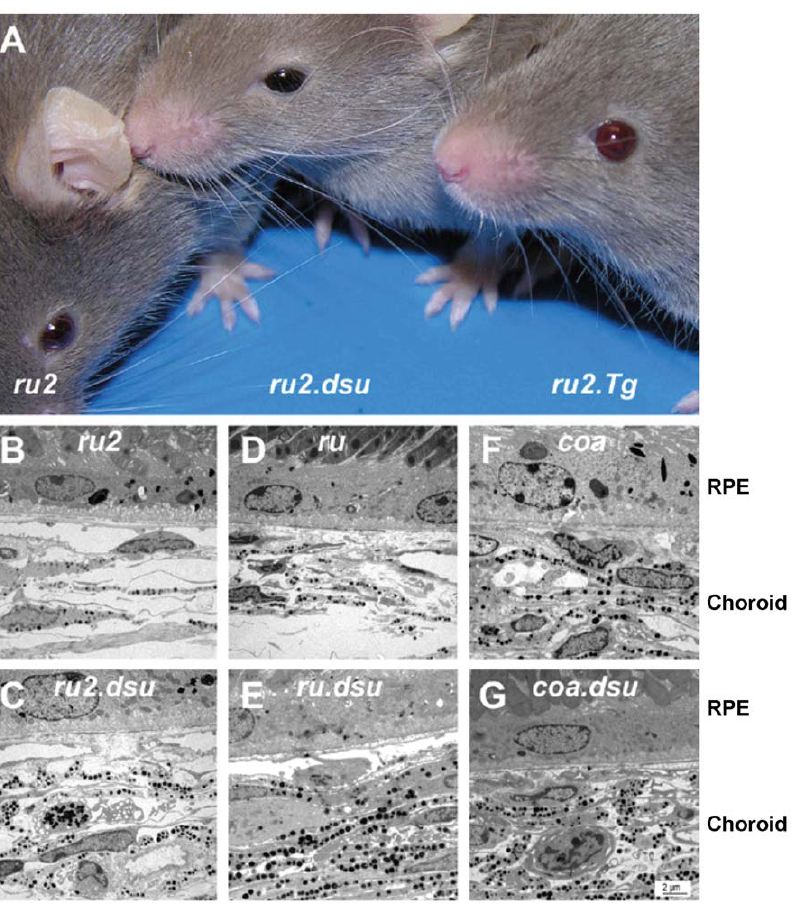
Figure 1. Melanoregulin levels modulate the eye color of HPS BLOC-2 mutant mice. A: Three month-old male mice of the genotypes indicated were photographed in ambient light. Note nearly black color of eyes of Hps5 ruby2J .Mreg dsu mice, darker than the eyes of Hps5 ruby2J mice, which are darker than those of the light ruby red Hps5 ruby2J .Mreg Tg eyes. B–G: Electron micrographs of sections through the RPE and choroid of Hps6 ruby , Hps5 ruby2J , and HPS3 coa mice, showing the lighter eye color in (A) to be secondary to decreased pigmentation of these layers. Note the effect of a melanoregulin loss of function ( Mreg dsu ) allele in enhancing pigmentation of the choroid in all three BLOC-2 mutants, Hps6 ruby , Hps5 ruby2J , and Hps3 coa . Scale bar=2 m m.